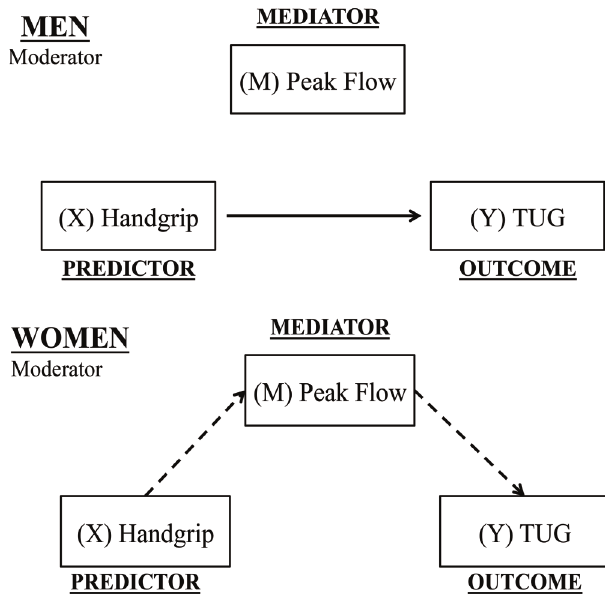
Figure 1 - Summary of the results. (X) Predictor variable; (M) mediator; (Y) outcome. In men, the association between the predictor (handgrip) and the outcome (TUG performance) had a direct effect (unmediated). In contrast, in women, the association between the predictor (handgrip) and the outcome (TUG performance) was mediated by peak